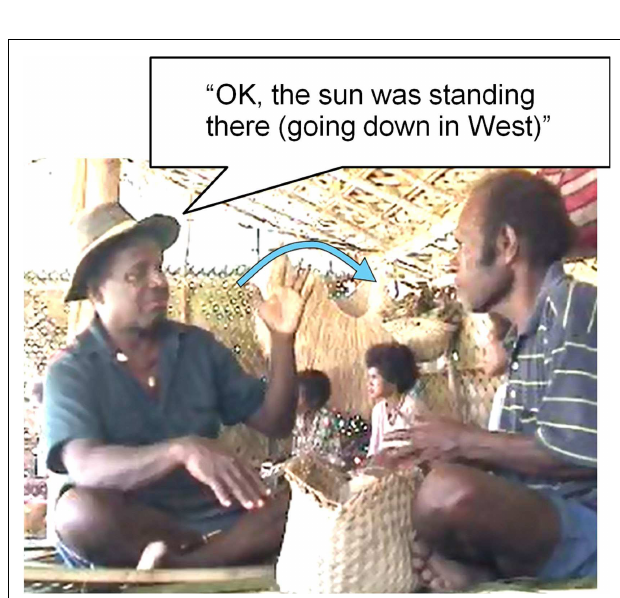
FIGURE 3 | Eye-pointing spatial location.